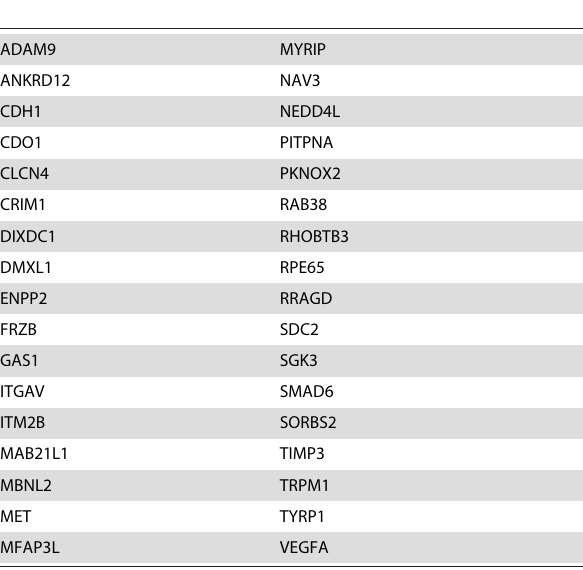
Table 3. RPE signature genes associated with downregulated